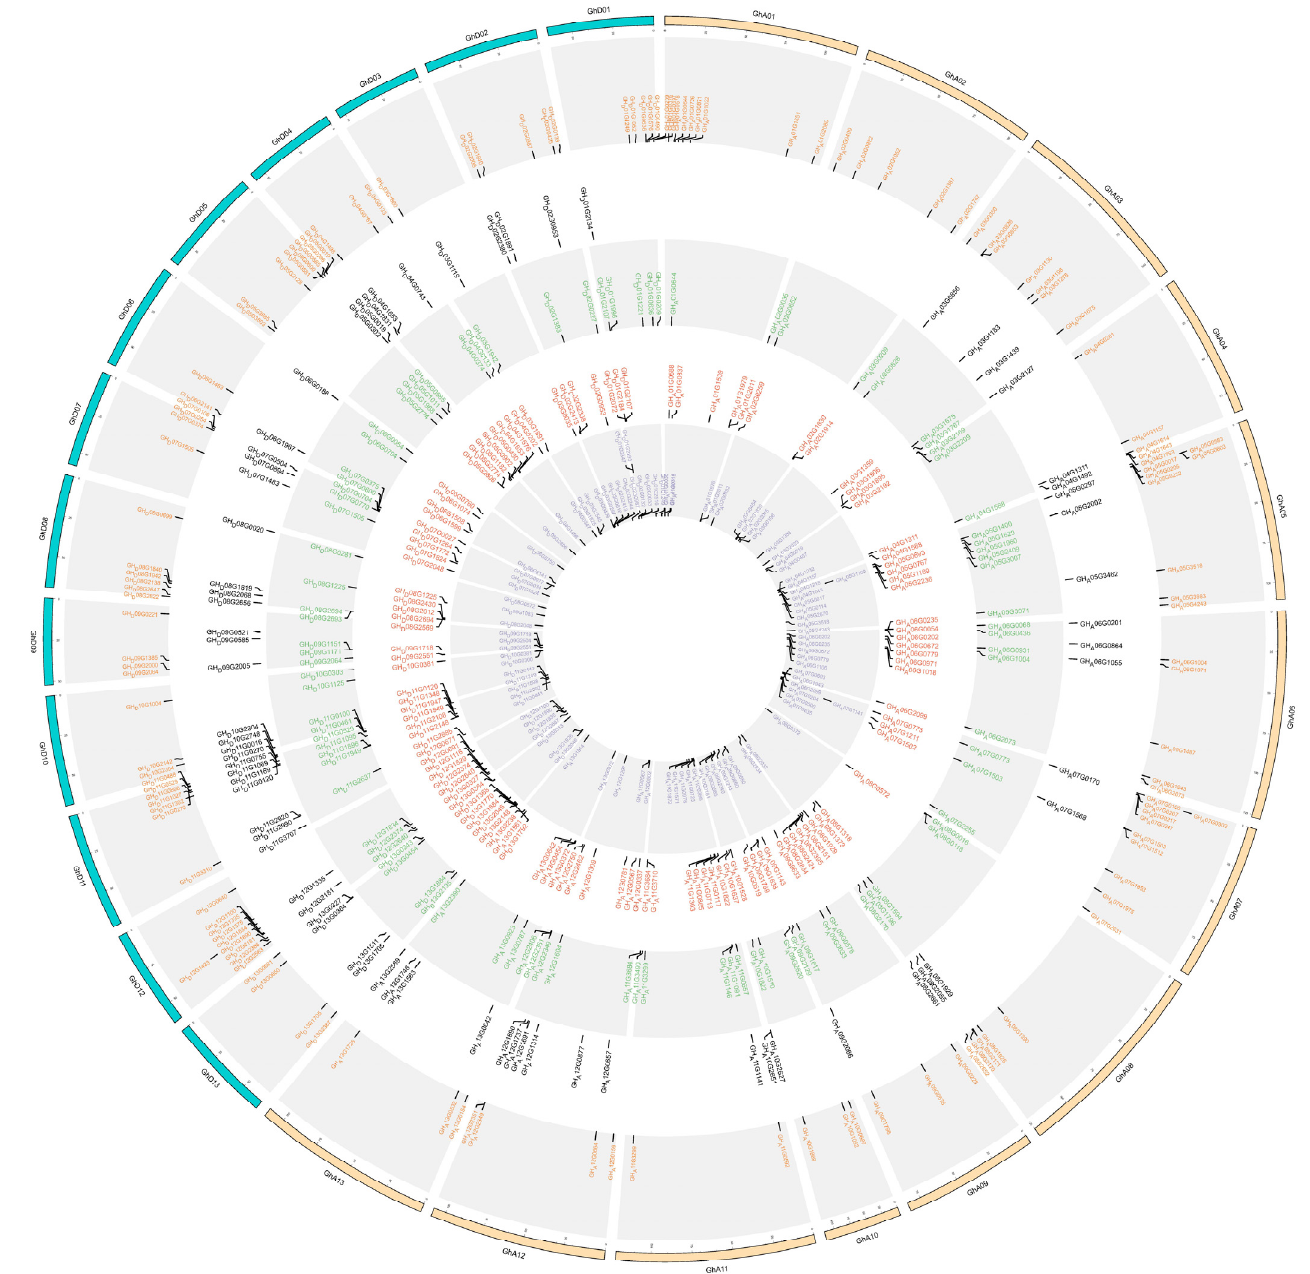
Figure 2. Distributions of the predicted TFs on chromosomes of the G.hirsutum . The gene color in the blue module under PEG stress is orange, while in the turquoise module is red. The gene color in the brown module under salinity stress is black, while in the blue module and turquoise is green and purple, respectively. Table 2. The prediction of the duplicated TFs in different modules.